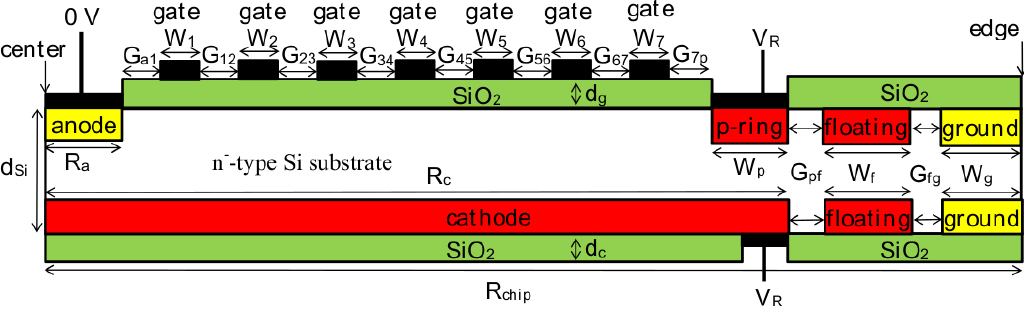
Figure 1. Half of a schematic cross section of a cylindrical GSDD structure with one